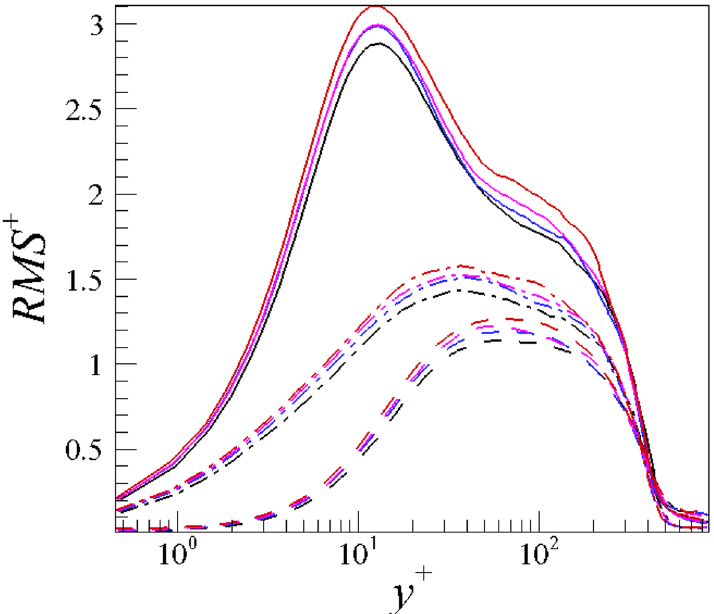
Fig. 11 Turbulence intensities versus inner scaling obtained at x